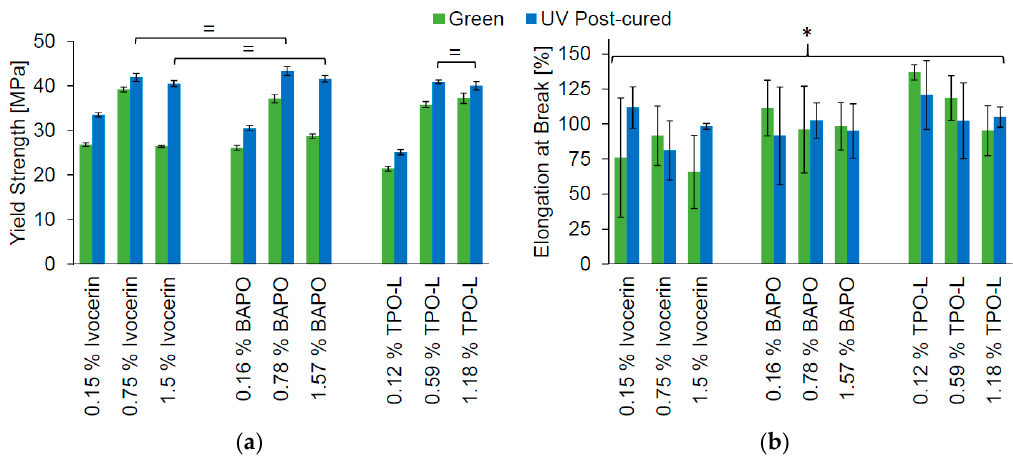
Figure 3. Influence of photoinitiator and its concentration on yield strength ( a ) and elongation at break ( b ) from tensile tests conducted in accordance with ISO 527-1:2012. Marks (=) show values of no significant difference for post-cured groups; * ANOVA showed no significant difference between all post-cured groups ( p = 0.09).